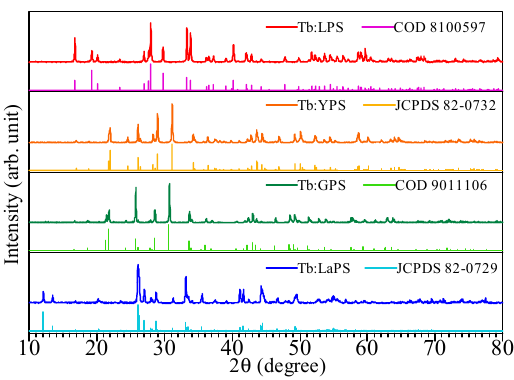
Figure 2. XRD pattern of Tb-doped LPS, YPS, GPS, and LaPS samples, with each individual reference pattern.